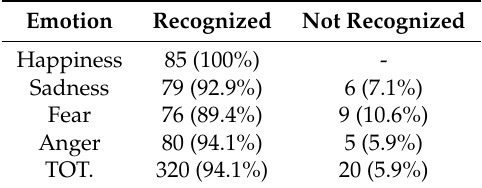
Table 5. Scores achieved by the Autism Spectrum Disorders (ASD) group in the FER